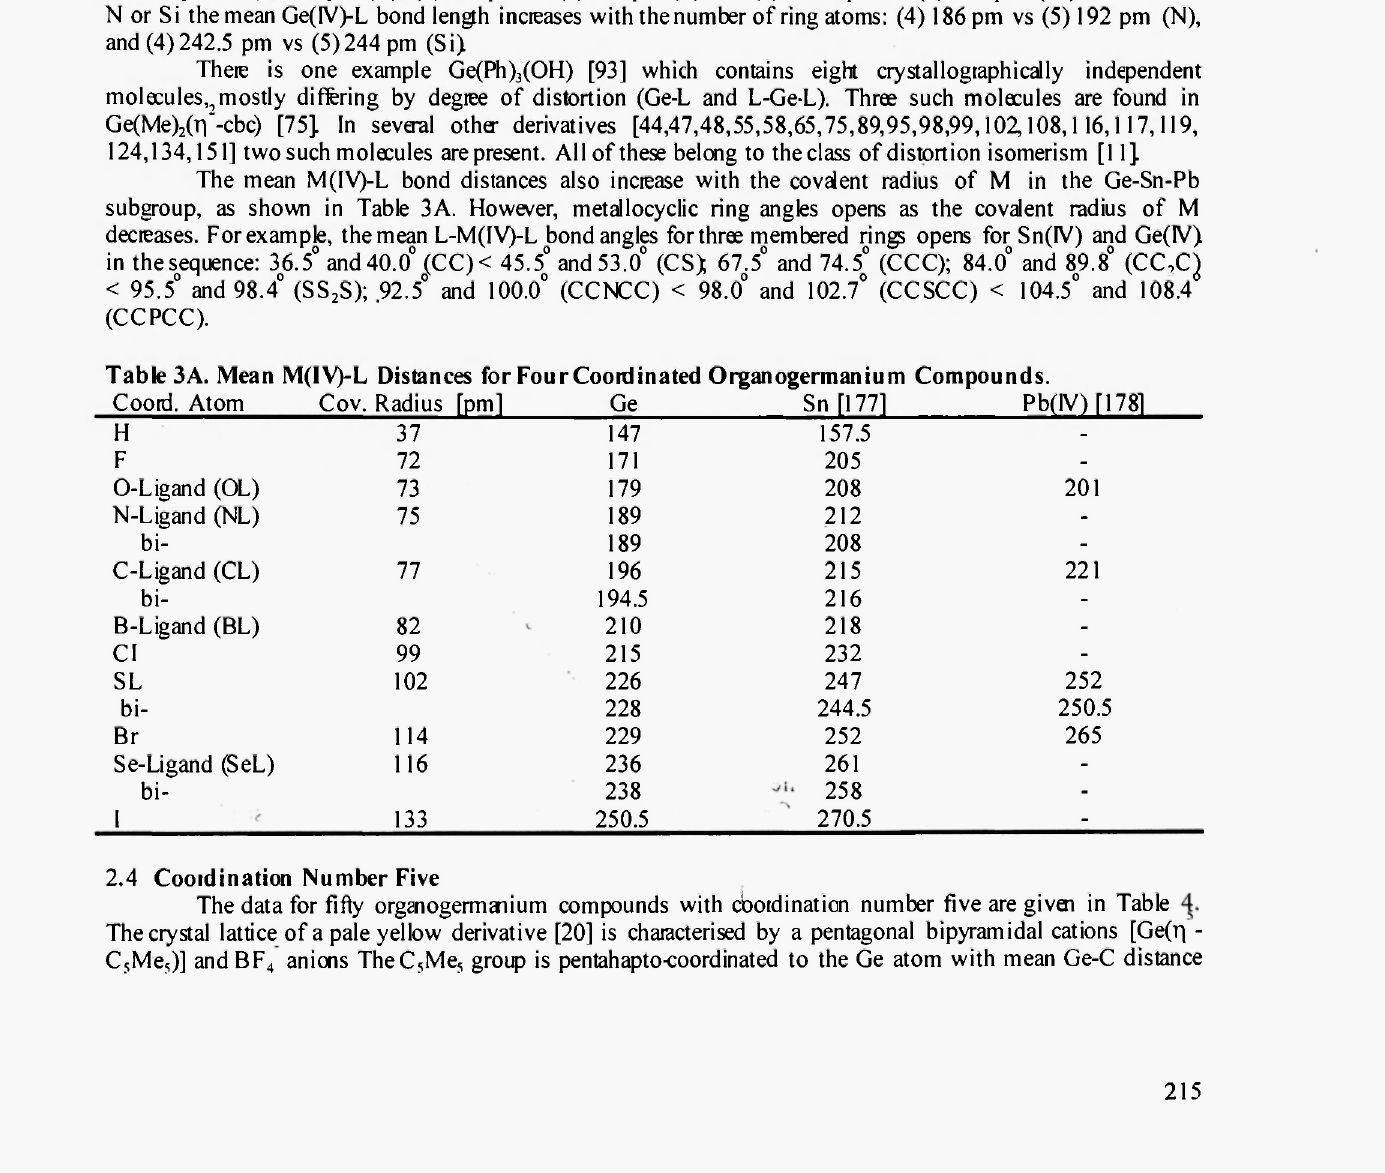
Table 3A. Mean M(IV)-L Distances for Four Coordinated Organogermanium Compounds. Cooid.